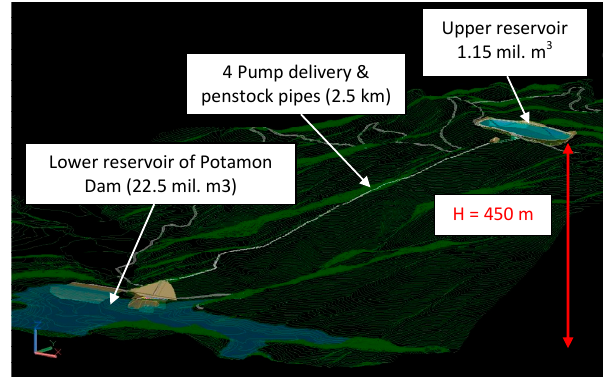
Figure 10. Schematic representation of Hybrid Power Station (HPS) in Potamon Dam.